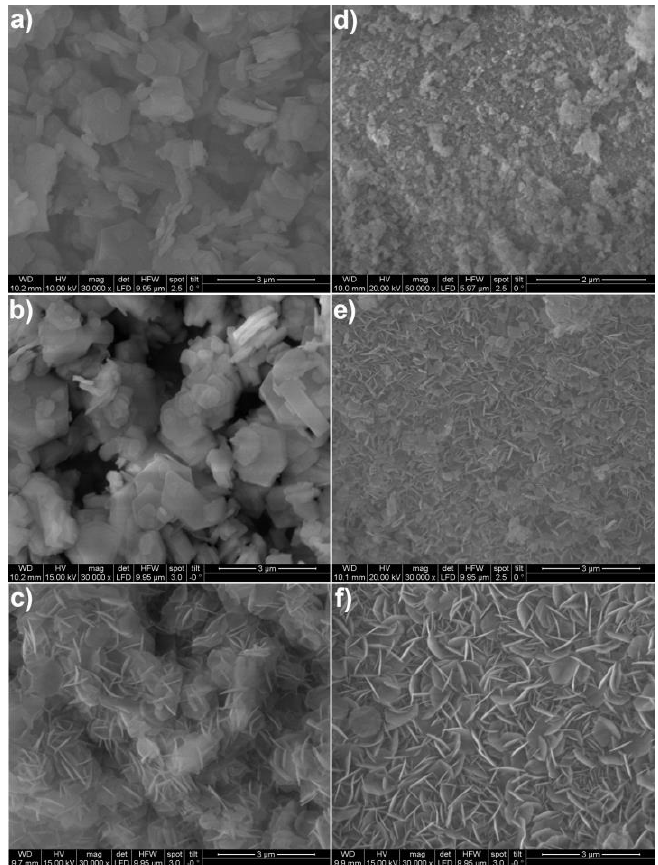
Figure 9. SEM images of various intermediates during calcination/rehydration/regeneration for Mg(OH) 2 - (left) and MgCO 3 -originating MgO (right); ( a ) Mg(OH) 2 -originating MgO; ( b ) Mg(OH) 2 -originating MgO after 5 rehydration – calcination cycles; ( c ) material of image b after regeneration for 24 h in liquid H 2 O; ( d ) MgCO 3 -originating MgO; ( e ) MgCO 3 -originating MgO after five rehydration – calcination cycles; ( f ) material of image e after regeneration for 24 h in liquid H 2 O.